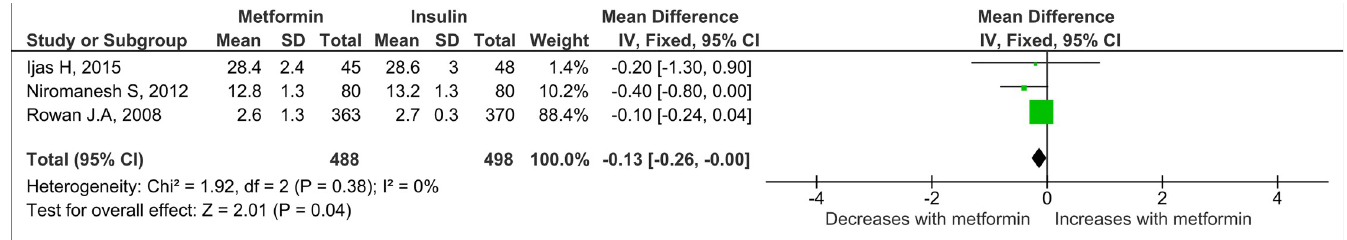
Fig 7. Neonatal ponderal index. Expressed as mean difference (fixed effects model) and 95% CI. IV, mean difference.